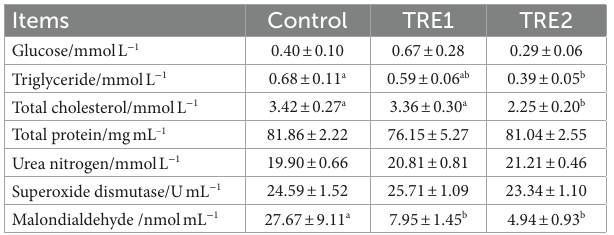
TABLE 4 Effects of feeding bamboo powder on the physicochemical indexes of feces of sows.